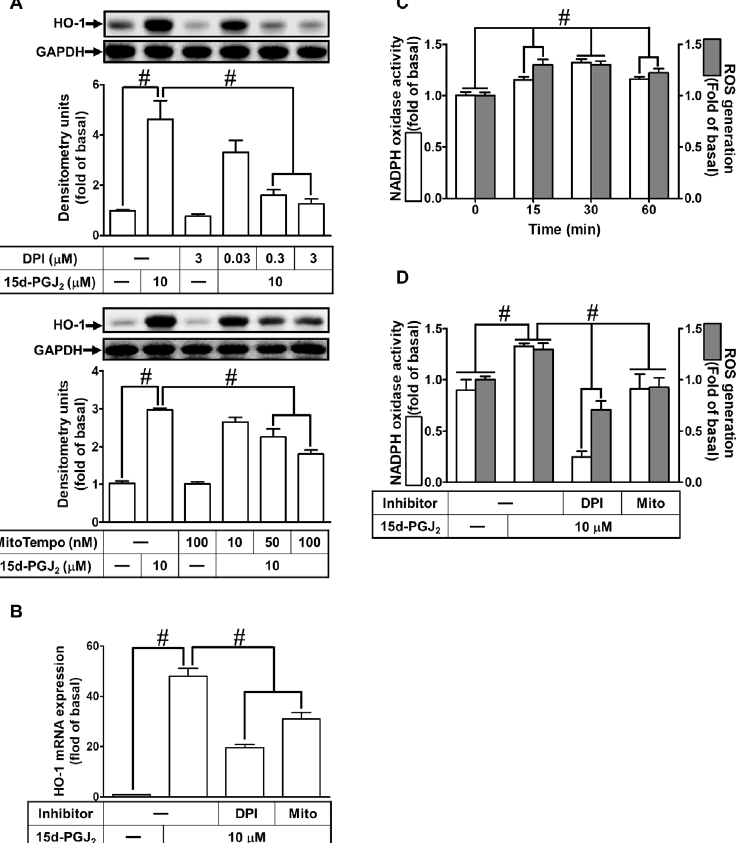
Figure 2. 15d-PGJ 2 induced expression of HO-1 in bEnd.3 cells via NOX activation and mitochon- dria-generated ROS. ( A ) The cells were pretreated with the indicated doses of DPI or MitoTempo for 1 h before incubation with 10 μM 15d-PGJ 2 for 6 h. To determine the HO-1 protein expression, the cell lysates were analyzed by Western blot with GAPDH as an internal control. ( B ) The cells were pretreated by 3 μM DPI or 100 nM MitoTempo for 1 h before incubation with 15d-PGJ 2 (10 μM) for 4 h. The HO-1 gene expression was analyzed by real-time PCR. ( C ) The cells were incubated with 10 μM 15d-PGJ 2 for 15, 30, and 60 min. ( D ) Cells were pretreated with MitoTempo (100 nM) or DPI (3 μM) for 1 h and then stimulated with 15d-PGJ 2 (10 μM) for 30 min. ( C , D ) The activity of NOX and ROS generation were measured by NOX activity assay and H 2 DCF-DA assay, respectively. Data are expressed as the mean ± S.E.M. of three independent experiments. # p < 0.01, as compared with